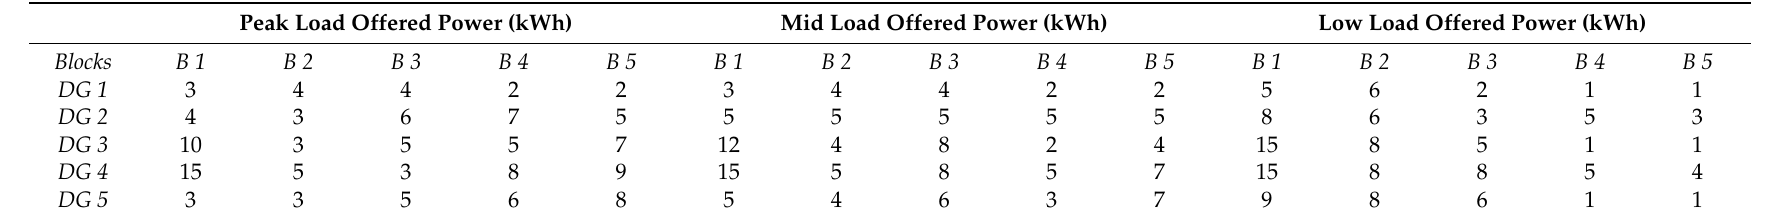
Table 3. Data of DGs’ offered active power